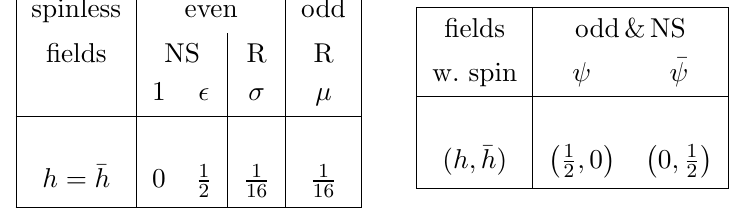
Table 2 . Virasoro primary (cid:12)elds in the fermionic Ising